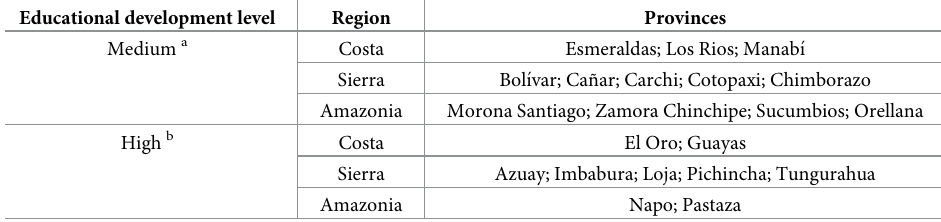
Table 1. Ecuadorian provinces according to their level of educational development